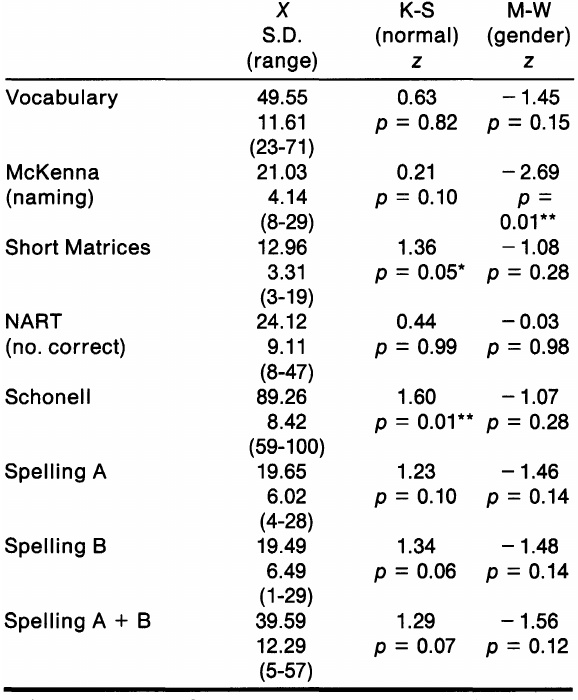
TABLE I. Characteristics of the normal subjects: means, standard deviations on each test with significance levels for tests of normality and gender differences (n